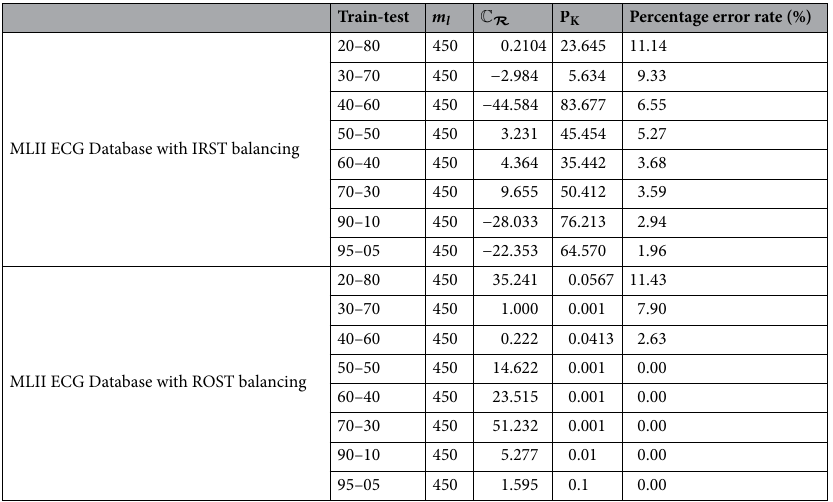
Table 7. Percentage error rate with values of m l , C R and P K obtained using proposed approach on MLII ECG database.